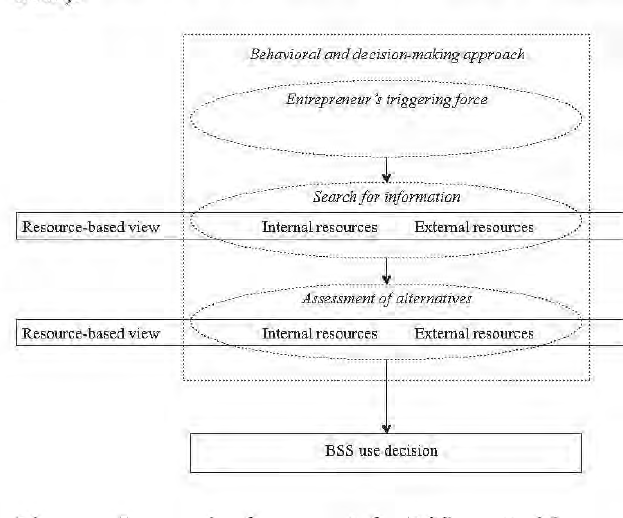
Figure 1: Integrative framework for BSS use decisions Internal triggering